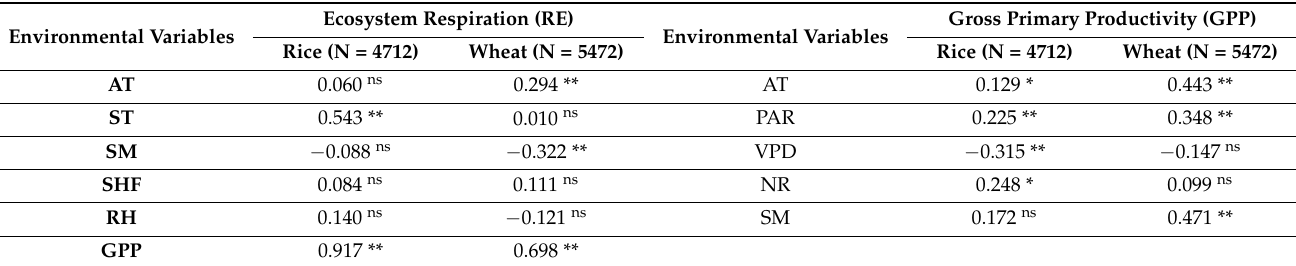
Table 2. Partial correlation coefficient between ecosystem respiration (RE), gross primary productivity (GPP) and related environmental variables.